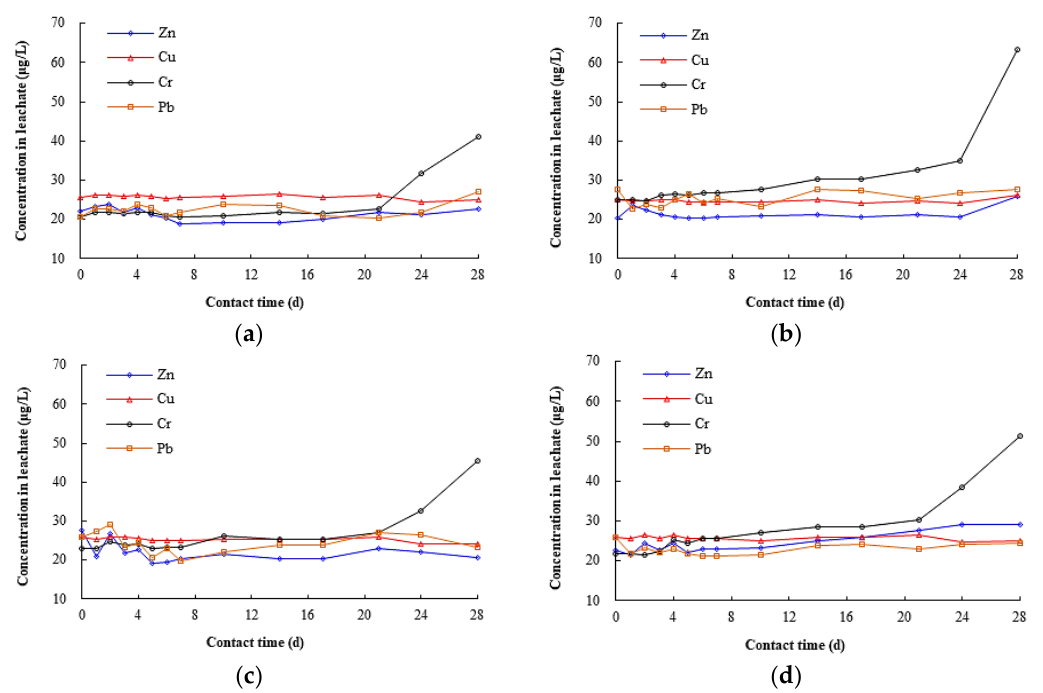
Figure 7. Variation of leaching concentrations of four heavy metals with contact time for PAC-13 specimens with and without MSWI-BAA: ( a ) PAC-13 without MSWI-BAA; ( b ) PAC-13 with MSWI-BAA of 0.075–2.36 mm; ( c ) PAC-13 with MSWI-BAA of 2.36–4.75 mm; and ( d ) PAC-13 with MSWI-BAA of 4.75–9.5 mm.